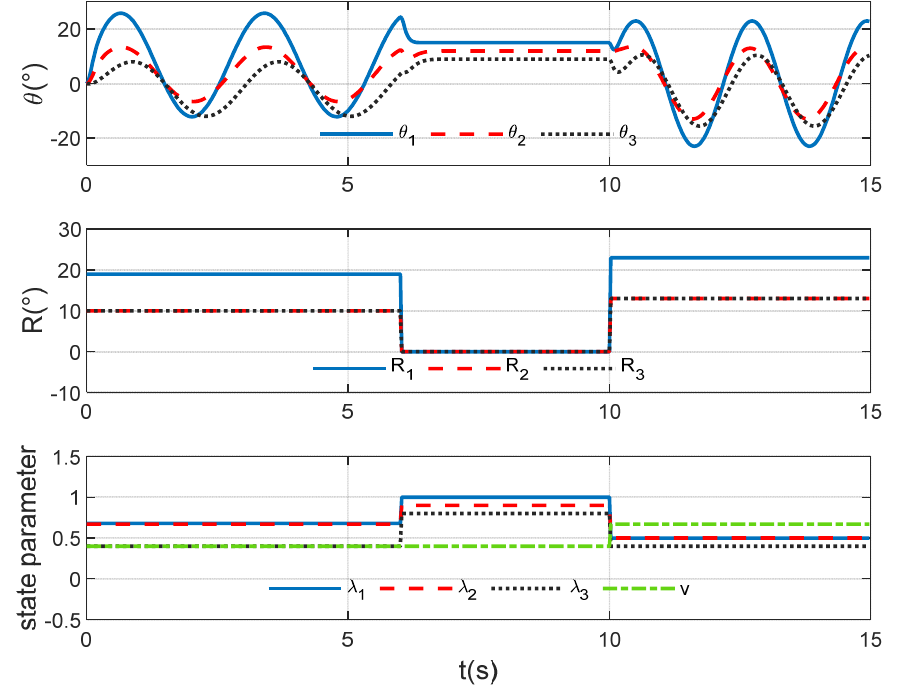
Figure 7. Forward swimming posture simulation diagram.